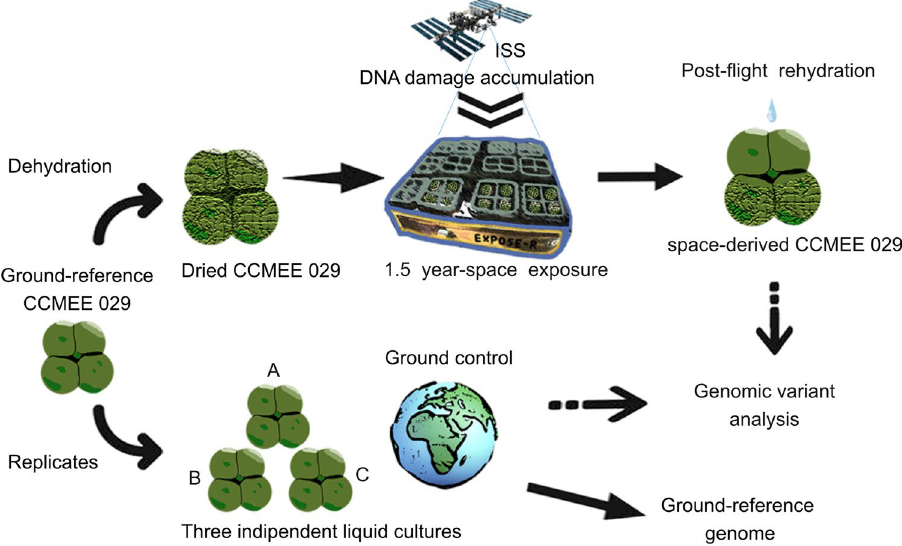
Figure 1. Experimental design. During the BIOMEX space experiment, dried cells of Chroococcidiopsis sp. CCMEE 029 were exposed to cosmic ionizing radiation combined with a Mars-like environment (UV radiation and atmosphere) simulated in LEO by using the ESA EXPOSE-R2 facility installed outside the ISS. The space-derivate was obtained upon rehydration of the exposed sample after retrieval to Earth.